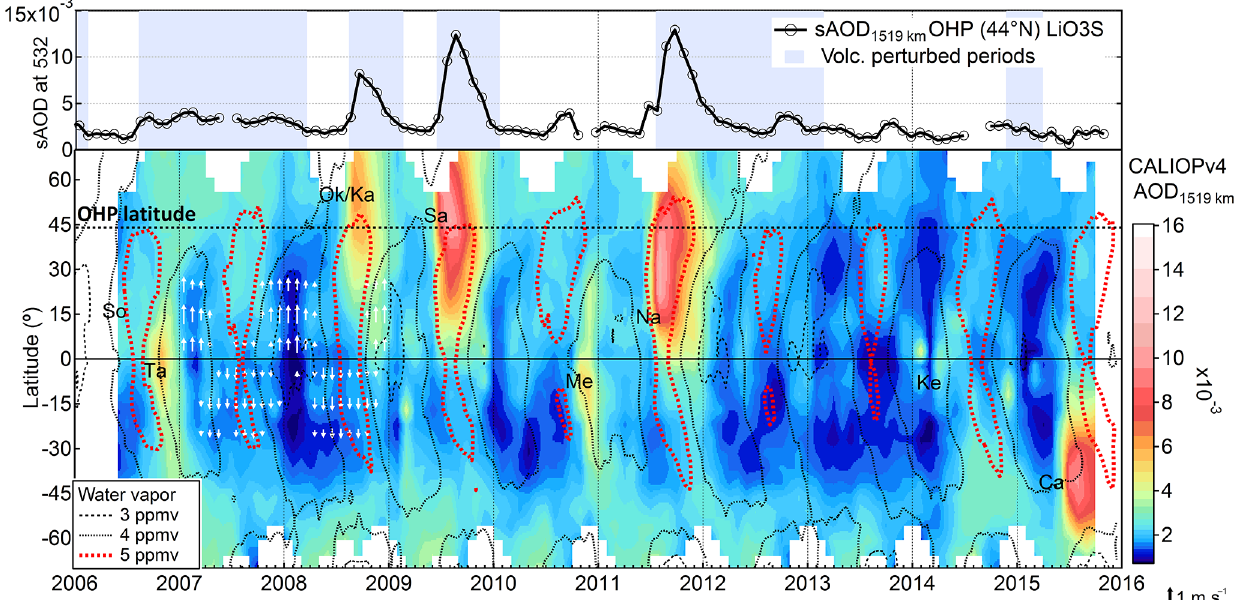
Figure 6. Time series of monthly mean sAOD 1519 from OHP LiO3S lidar (top) and time–latitude section of zonal-mean AOD 1519 from CALIOP in log-scaled color map with indications of VEI 4 eruptions (bottom). Time periods considered as perturbed by volcanism (Table 3) are shaded light blue in the top panel. White arrows (in 2007–2008) represent the mean meridional component of monthly and zonally averaged horizontal wind at 100hPa from ERA-Interim reanalysis. Dashed and dotted contours depict the zonal-mean water vapor mixing ratio at 100hPa from Aura